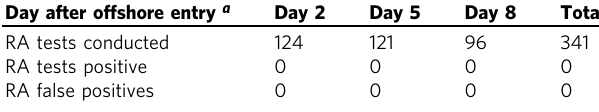
a BP platform test data, 5 March 2021 to 24 May 2021.